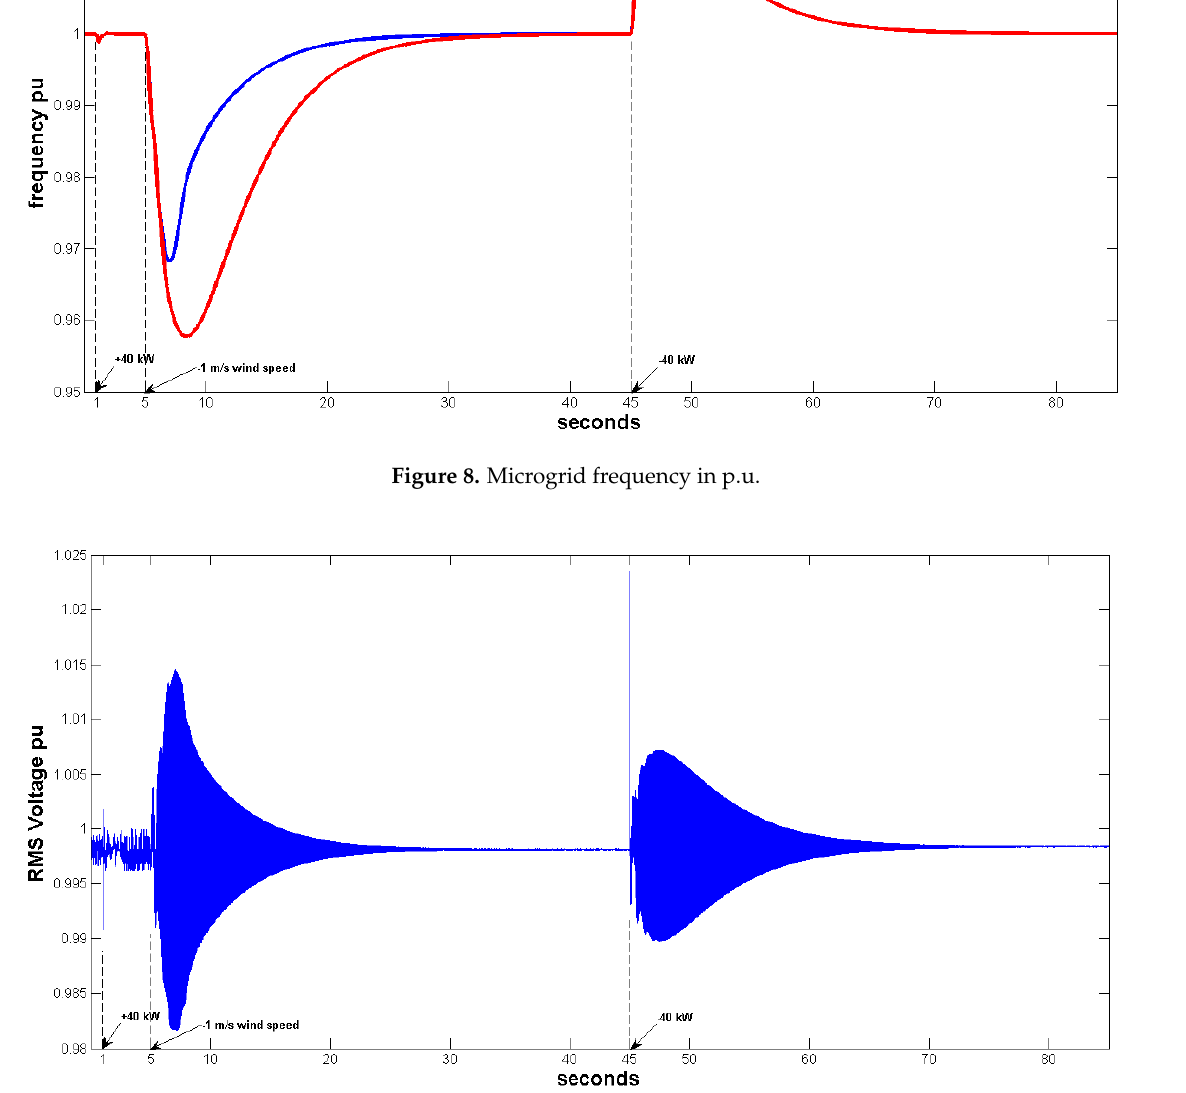
Figure 9. Microgrid RMS voltage in